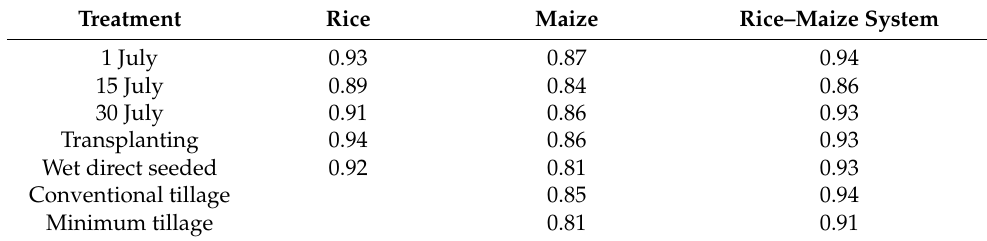
Table 6. Sustainable yield index of rice, maize, and rice–maize system. Treatment